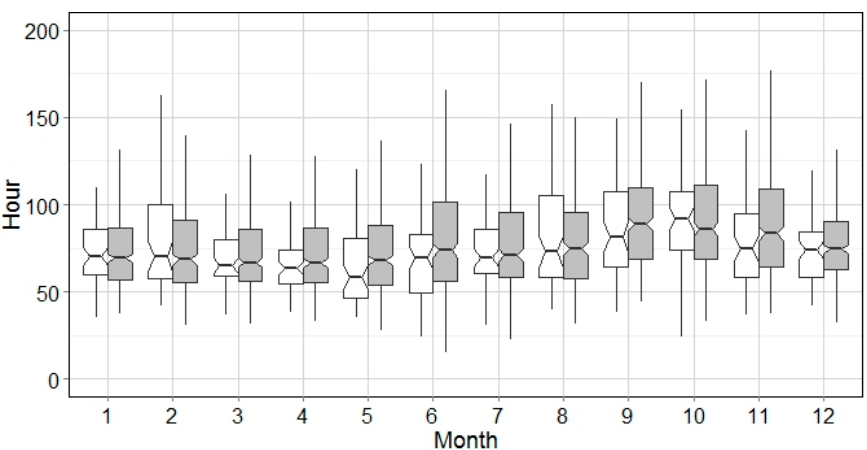
Figure 6. Boxplots of Dry Event Duration (DED) means (Historical: White, Synthetic: Grey).